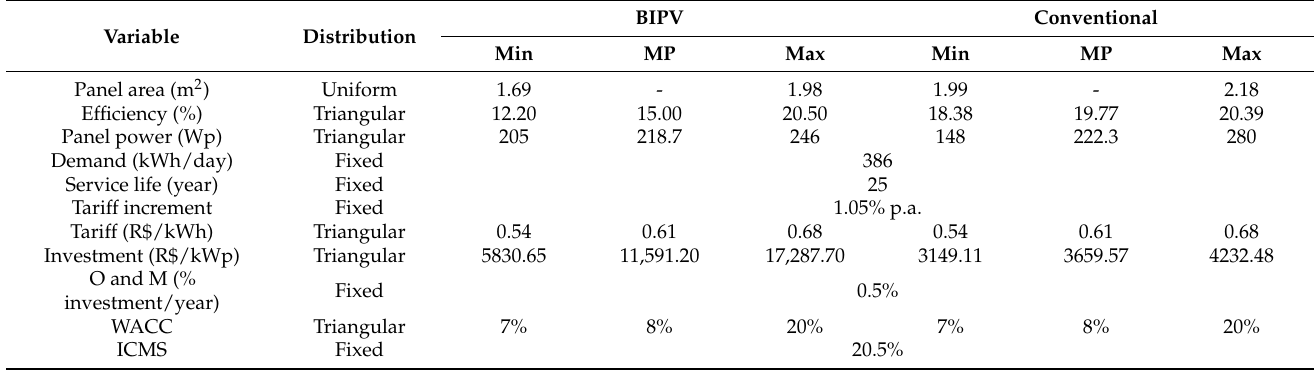
Table 6. Input data used in stochastic simulations of NPVs (only Pau dos